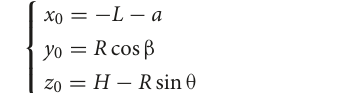
The action range of the shield shell friction is from the cutter head to the shield tail, assuming that the shield shell friction is evenly distributed on the shield shell. The shield friction can also be regarded as a horizontal acting load. The friction dP h = fRd β ds on the shield shell per unit area, the coordinates of any point on the shield shell can be expressed